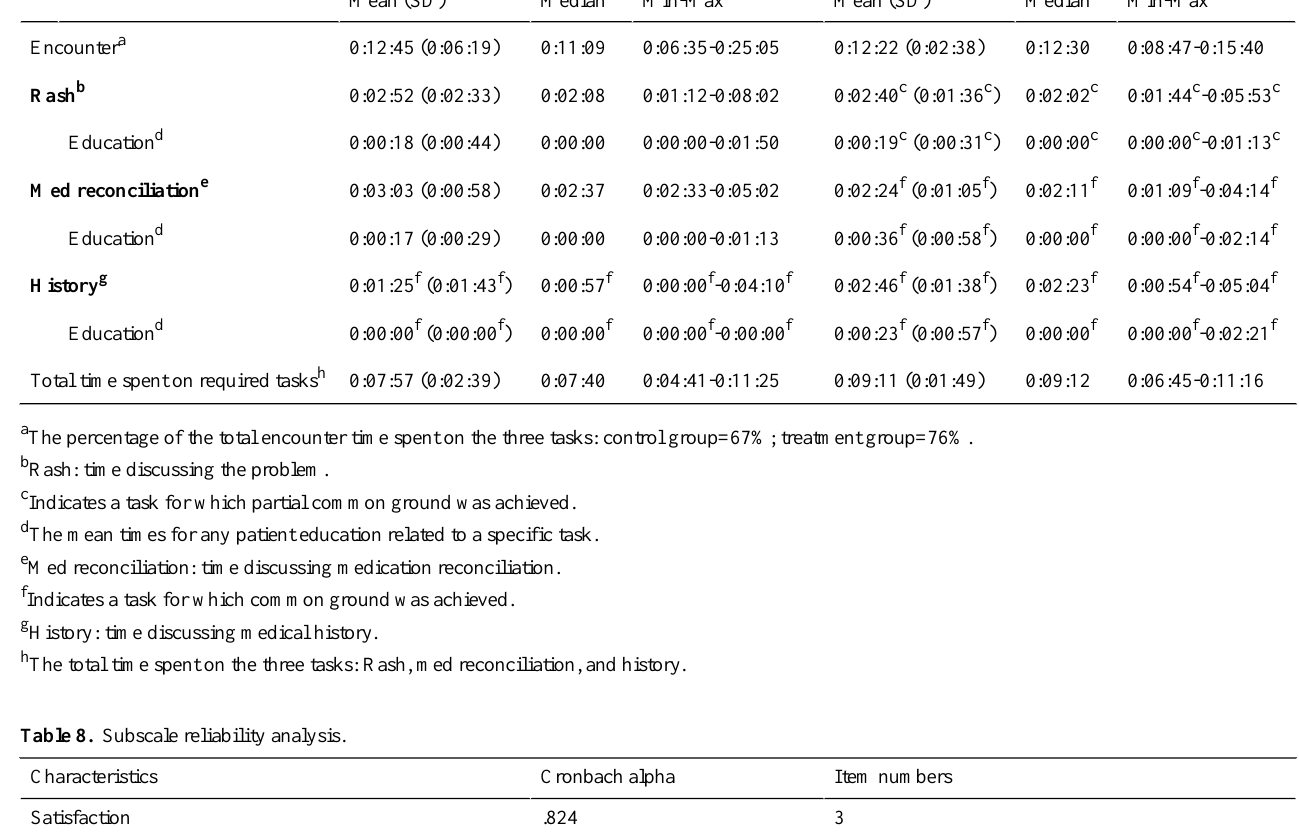
Treatment groupControl groupTask